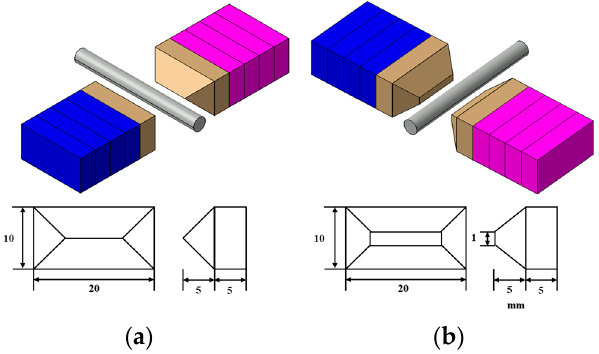
Figure 4. Experimental conditions for the two kinds of magnetic pole types. ( a ) The sharp shape; ( b ) a 1 mm linear shape.